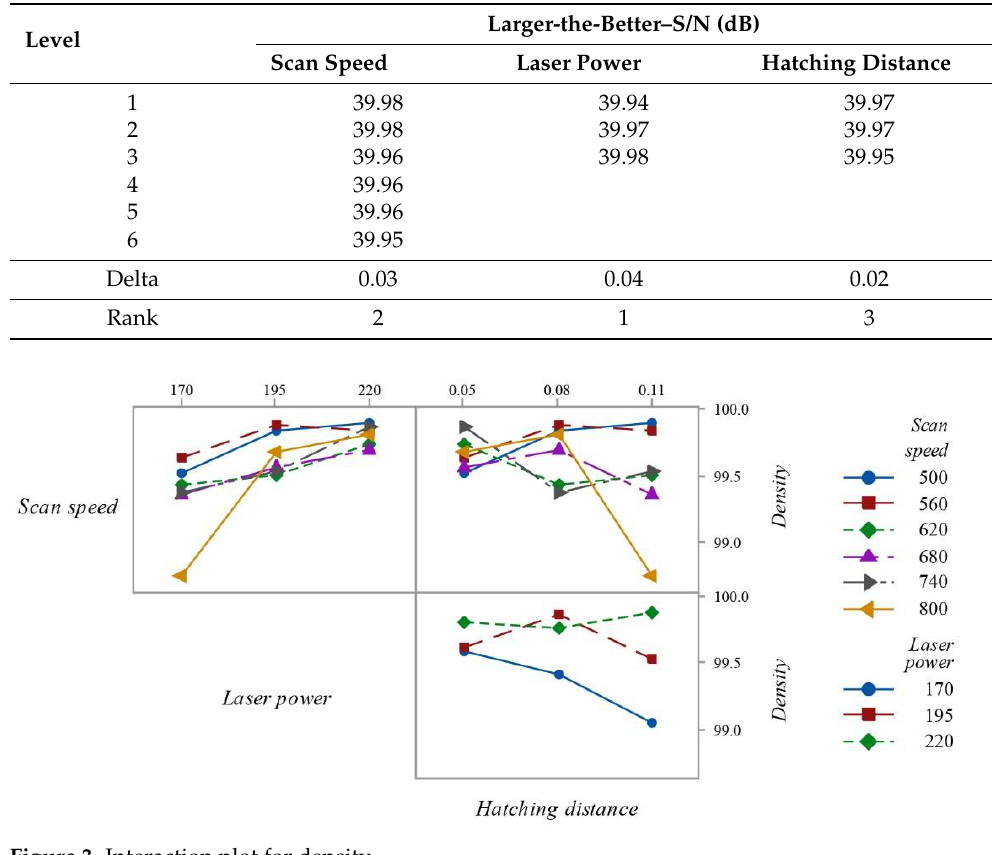
Figure 3. Interaction plot for density.